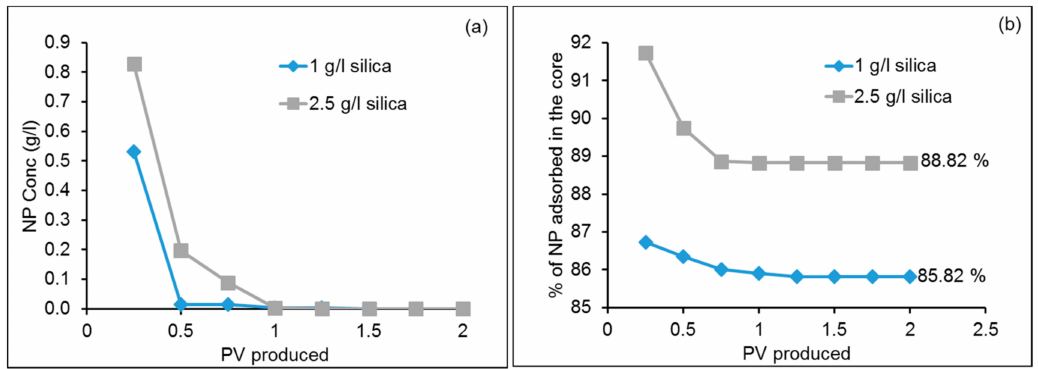
Figure 3. ( a ) Effluent NP concentration profiles; ( b ) % adsorbed NP during post flush. PV: Pore